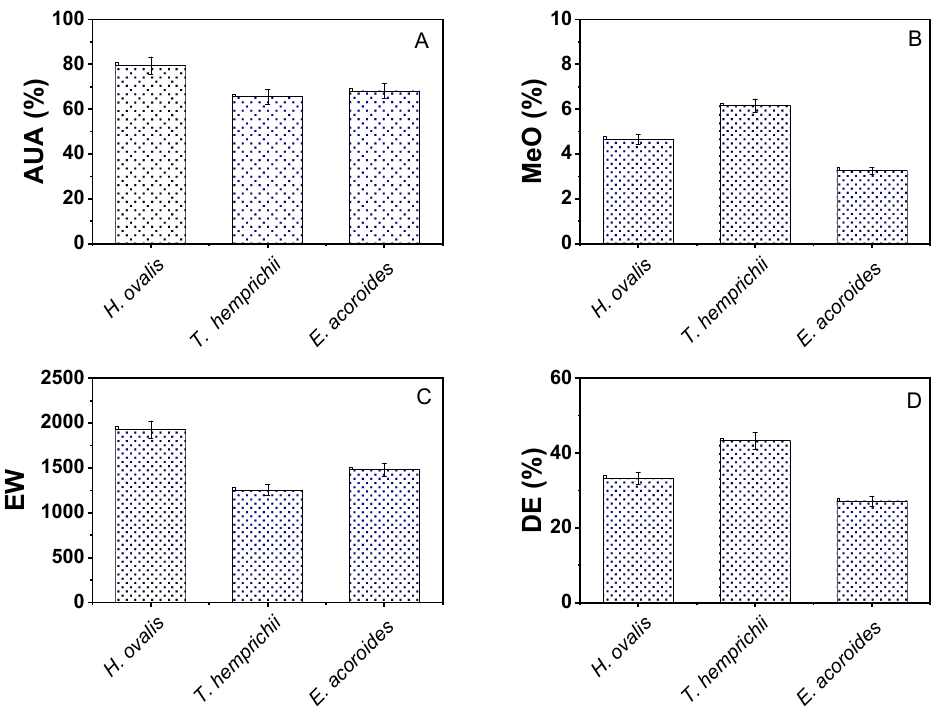
Figure 2. Anhydrouronic acid content ( A ), methoxyl content ( B ), equivalent weight ( C ), degree of esterification of pectin from three Vietnamese seagrass species ( D ).